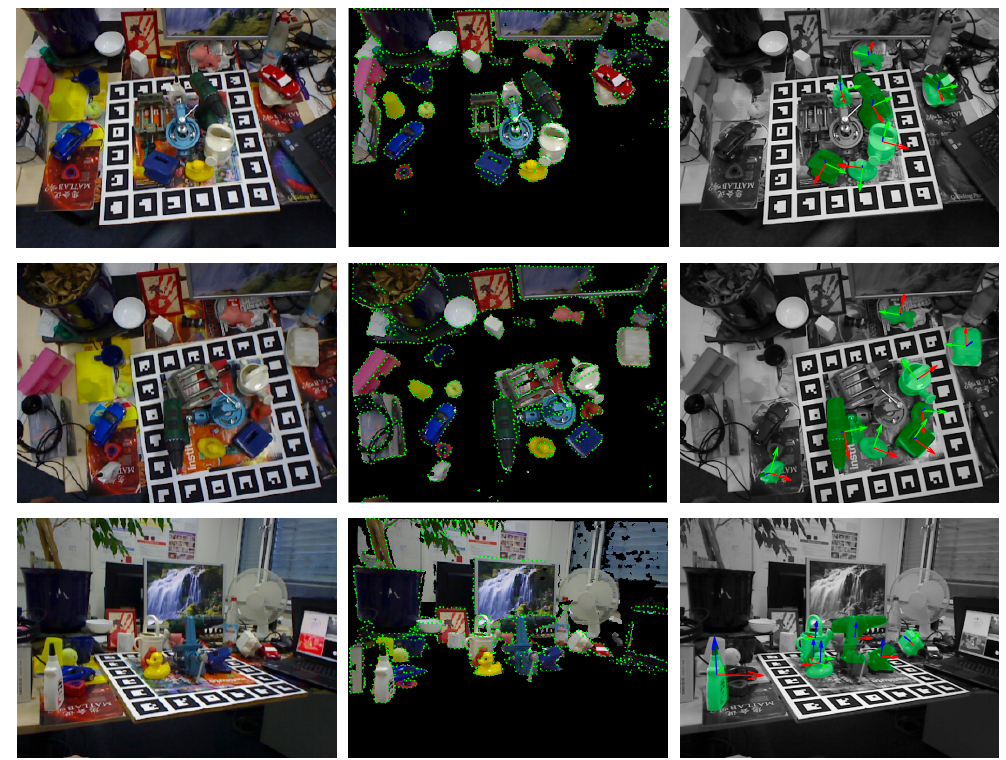
Figure 12. Some detection results on the Occlusion dataset.